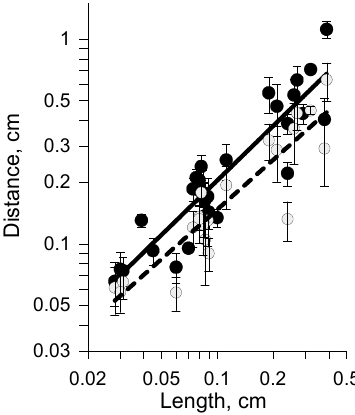
Figure 9. Distance covered during total kick phase ( ● ) and stroke phase ( ○ ) approximated as S kick = 1.55 L 0.88 (R 2 = 0.84) and S st = 0.93 L 0.8 (R 2 = 0.82), respectively.